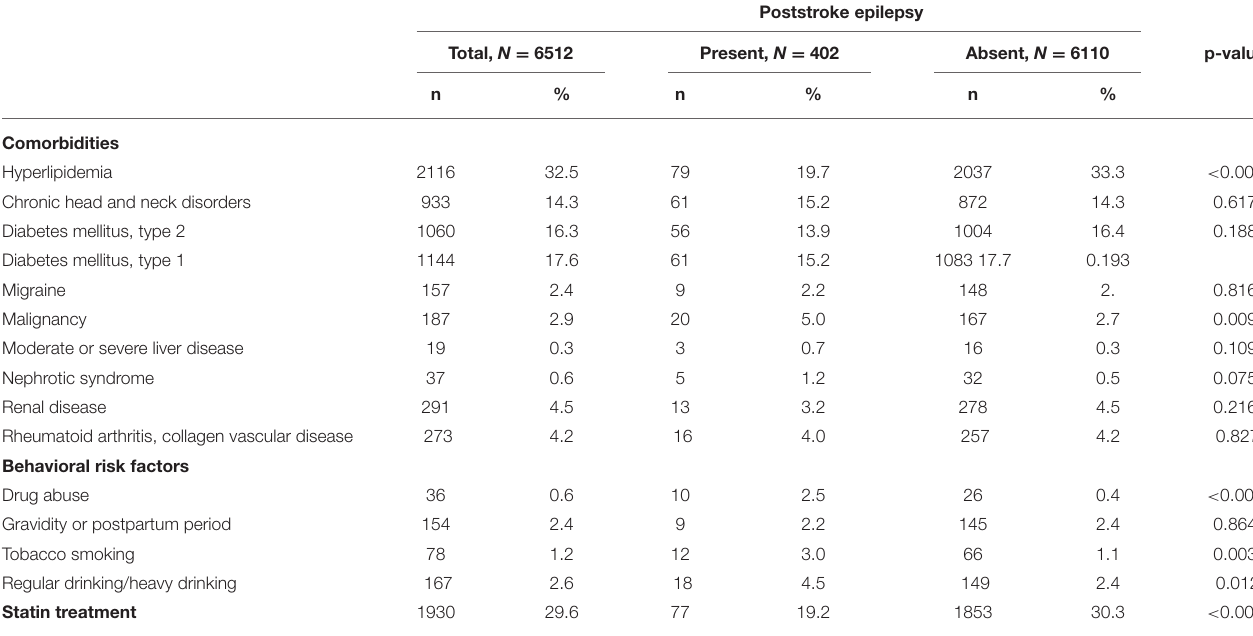
TABLE 3 | Stroke risk factors and underlying conditions in PSE